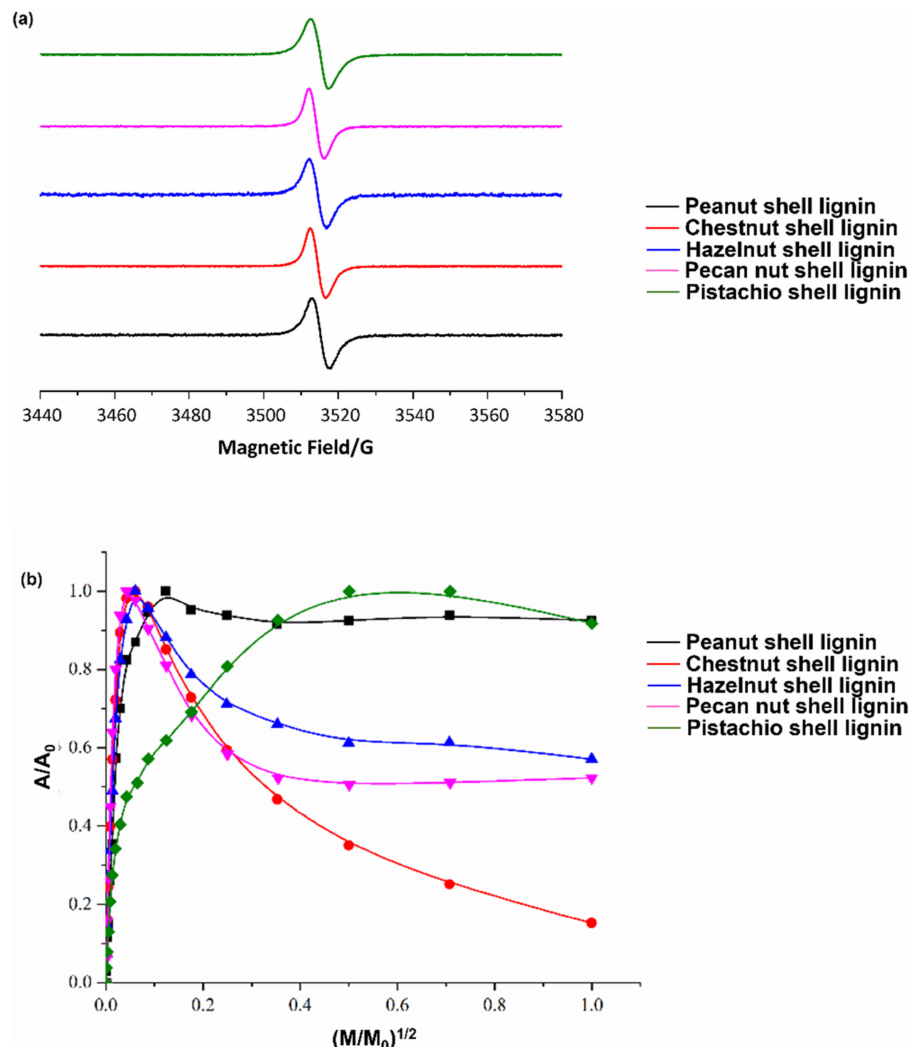
Figure 1. ( a ) Solid-state EPR spectra and ( b ) power saturation profiles of lignins recovered from the different nut